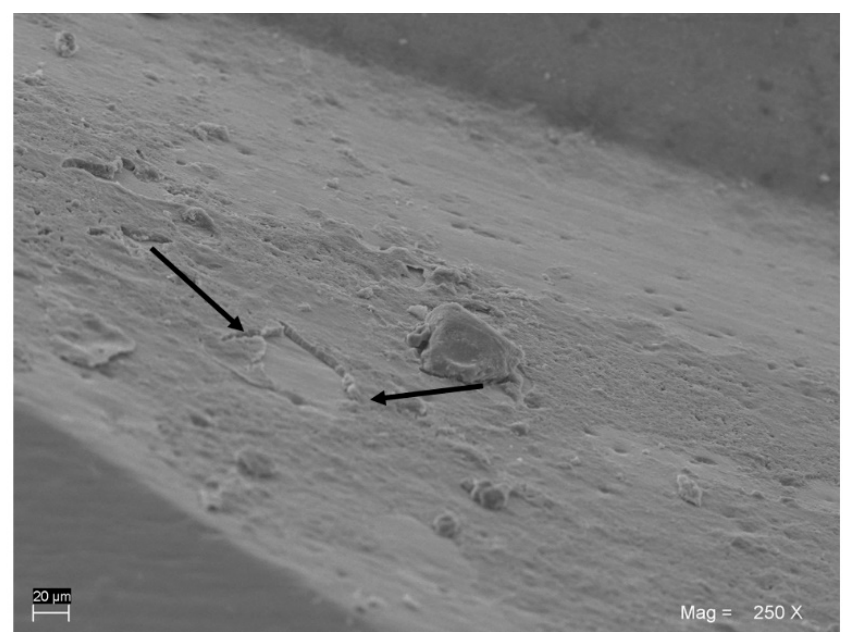
Figure 2. Group 1. Aspects of the steel drill after 50 disinfection cycles with glutaraldehyde, where zones of structural alteration can be observed.